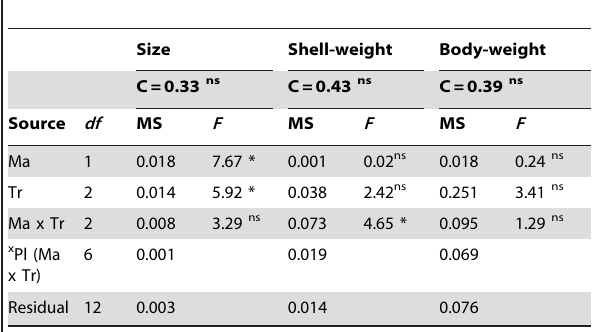
Table 2. Analyses of changes in size, shell-weight and body- weight of small